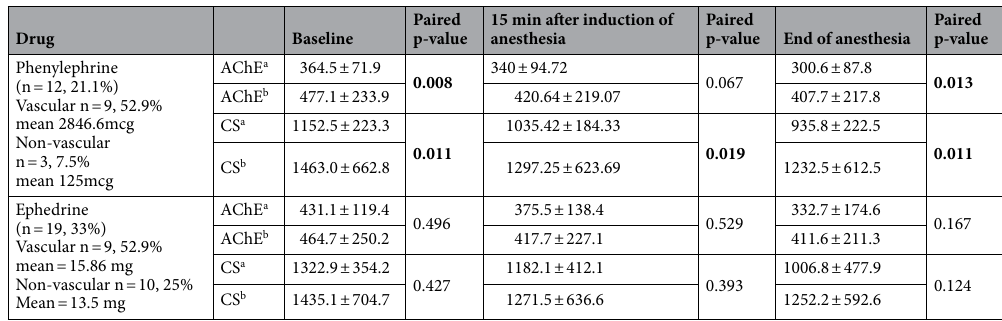
Table 3. The effect of vasopressor drugs on Cholinesterase activities. AChE Acetylcholinesterase, CS Cholinergic status, both measured in nmol/min/ml. a Treated. b Not treated.